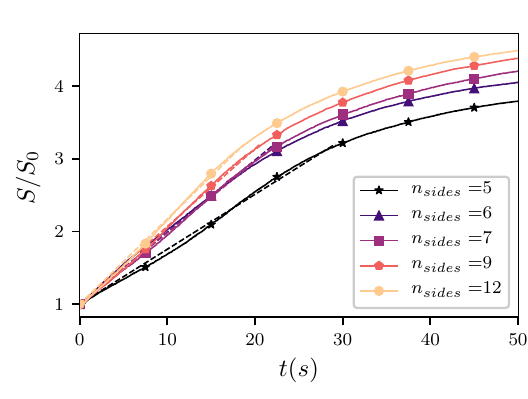
Figure 2. Specific surface S normalized by its initial value S 0 for each sample of polygons with di ↵ erent numbers of sides n sides